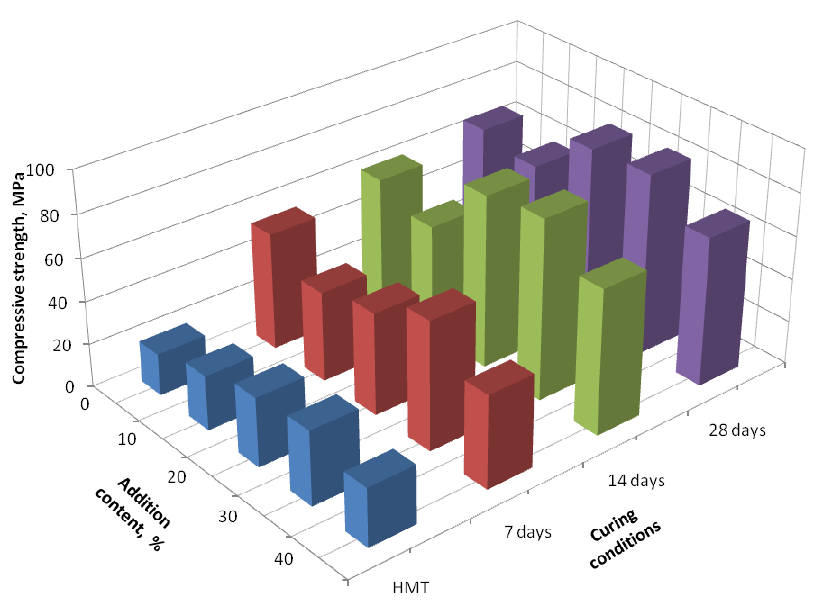
Figure 5. Dependence of the strength of the binders with di ff erent amounts of additives on the hardening